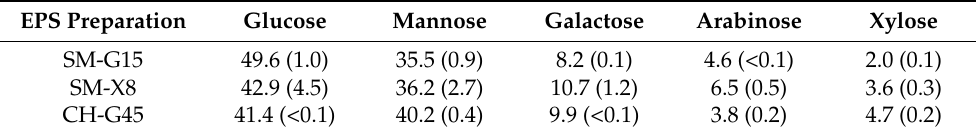
Table 4. Relative ratio of monosaccharide units in the EPS produced by cultivation of B. atrophaeus BU4 in xylose- (SM-X8) and glucose-based (SM-G15) synthetic media and in a quinoa stalk cellu- losic hydrolysate (CH-G45). Values are mass fractions in percent based on the total mass of the identified sugars.